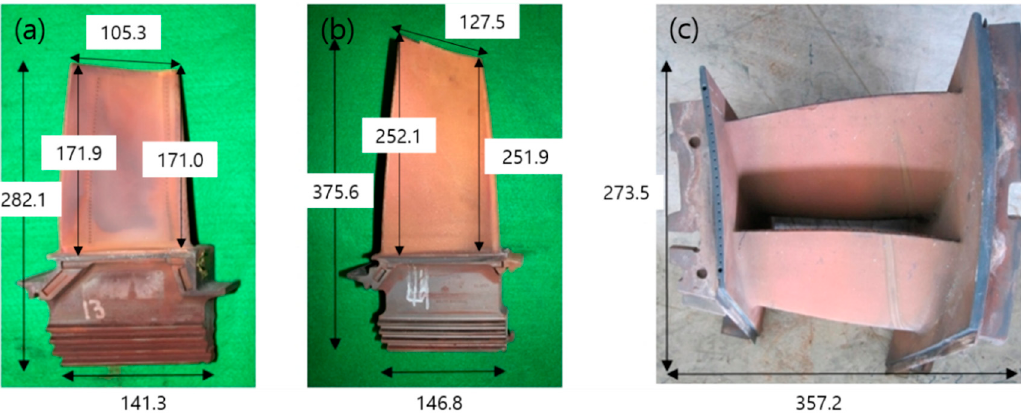
Figure 1. Service-exposed hot gas pass components (HGPCs): ( a ) first-stage blade, ( b ) second-stage blade, and ( c ) second-stage vane (unit: mm).